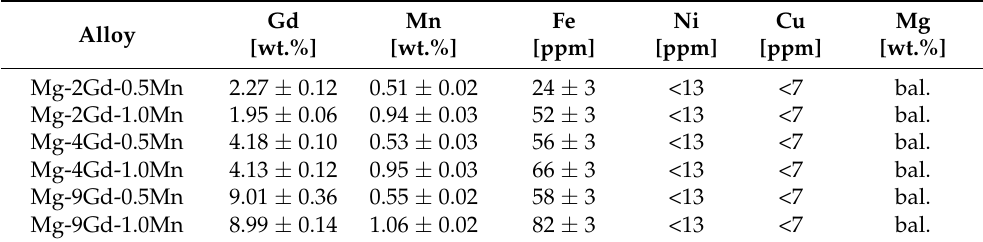
Table 1. Compositions with standard deviation of alloys in as cast condition. Contents of Gd and Mn were measured by inductively coupled plasma optical emission spectrometry, whereas levels of Fe, Cu and Ni were determined by spark emission spectroscopy.